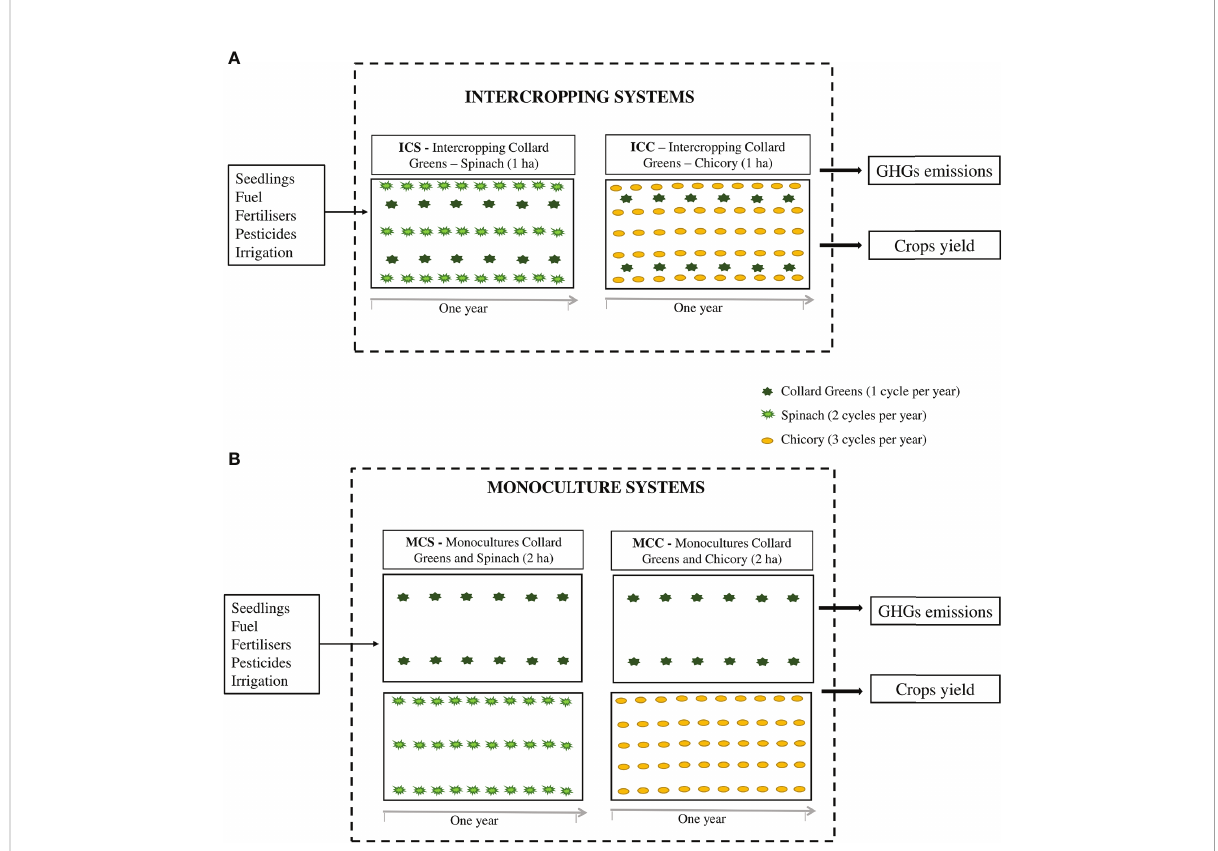
FIGURE 1 Vegetable production scenarios evaluated: (A) intercropping: ICS – intercropping of collard greens and spinach (area of 1 ha); ICC – intercropping of collard greens and chicory (area 1 ha); (B) monocultures: MCS – monocultures of collard greens and spinach (2 ha); MCC – monocultures of collard greens and chicory (2 ha); and their respective sources of GHG emissions during one agricultural year of